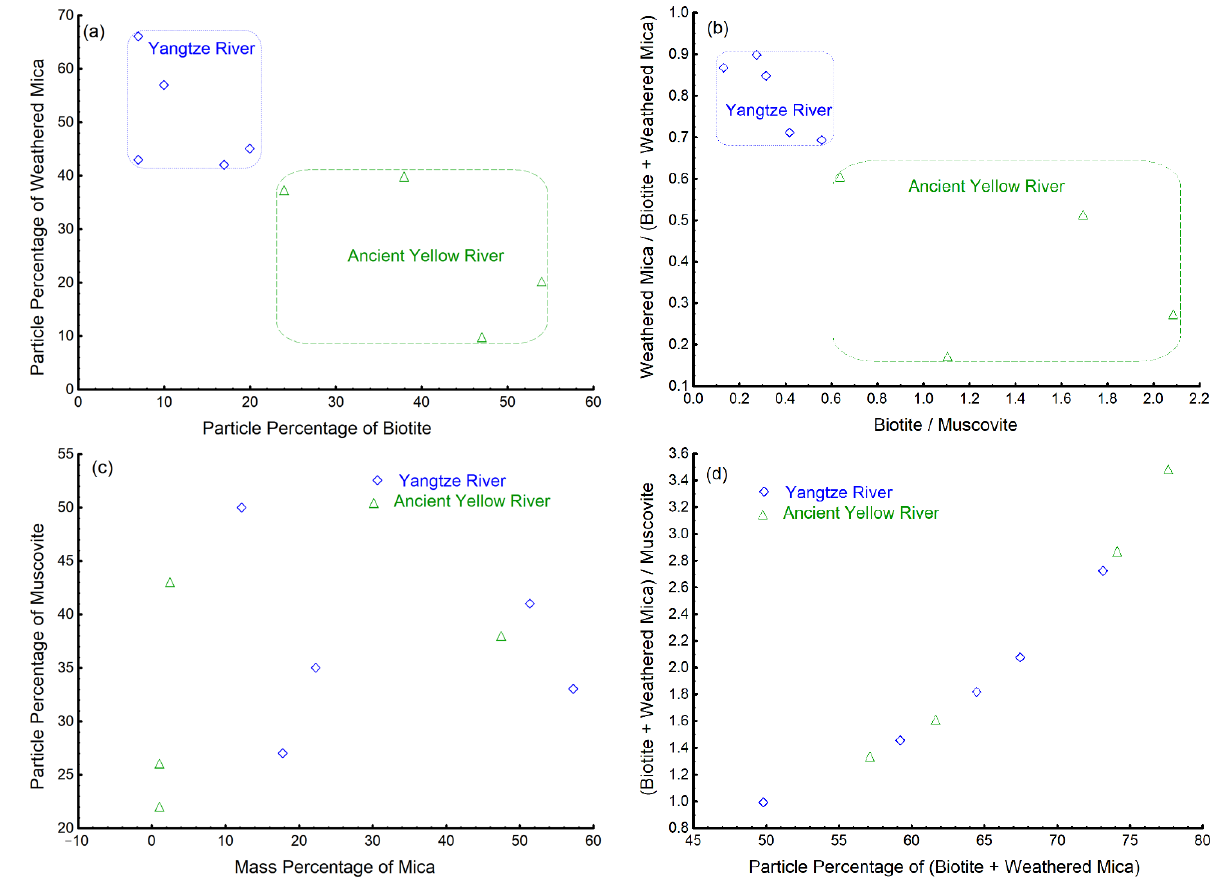
Figure 8. Index scatter diagrams of detrital mica in the very fine sand fraction of the sediments of the Yangtze River Estuary and ancient Yellow River Estuary; ( a ) particle percentage of biotite; ( b ) particle percentage ratio of weathered mica to the sum of biotite; ( c ) particle percentage of weathered mica; ( d ) weathered mica and particle percentage ratio of biotite to muscovite, significantly differ between the Yangtze River Estuary and ancient Yellow River Estuary.